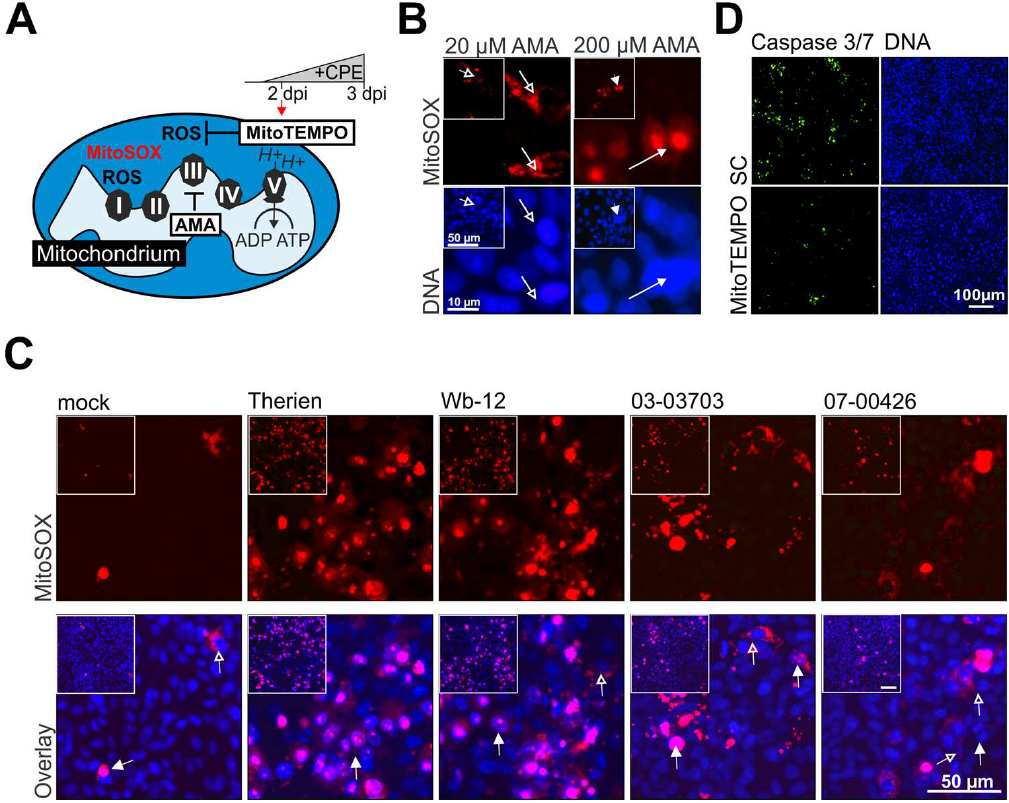
Figure 3. MitoSOX staining of RV-infected cells revealed the presence of mitochondrial superoxide and suggests mitochondrial dysfunction through its nuclear translocation. ( A ) Overview of the application scheme of superoxide detection by MitoSOX dye and scavenging by MitoTEMPO; ( B ) Depending on the applied concentration of antimycin A (AMA), MitoSOX stains a mitochondria-confined region in the cytoplasm (at 20 µ M, open arrow) or within the nucleus (at 200 µ M, closed arrow). The insets depict the corresponding microscopic field at a lower magnification; ( C ) At 3 dpi mock- and RV-infected Vero cells were incubated with MitoSOX and subjected to fluorescence microscopy. The inset provides the corresponding overview of the area depicted at higher magnification. The localization of the dye is indicated by open arrows for mitochondrial and closed arrows for nuclear localization; ( D ) At 2 dpi the mitochondrial antioxidant MitoTEMPO was added to Therien-infected Vero cells to assess its effect on apoptosis as compared to control cells in the absence of the scavenger (SC). Induction of apoptosis was monitored through activation of caspase 3/7. Activated caspase activity results in generation of a fluorescence signal after cleavage of the DEVD peptide from the fluorophore.